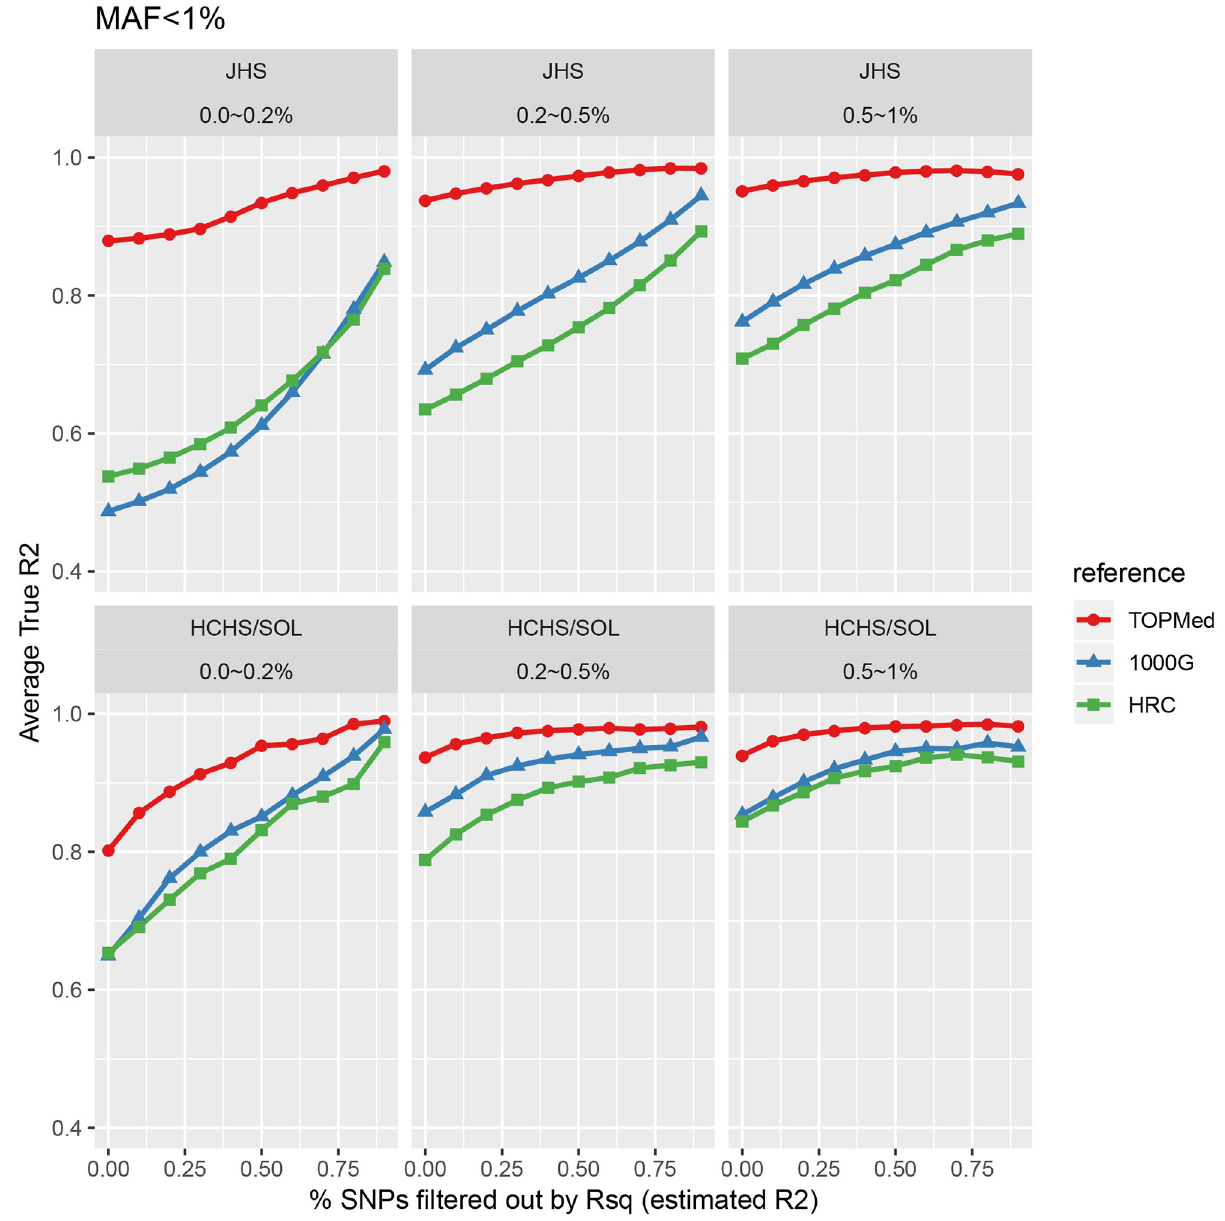
Fig 1. Comparison of imputation reference panels, for variants with MAF < 1%. Imputation quality (measured by true R2 [Y-axis]) is plotted with progressively more stringent post-imputation filtering from left to right, with filtering according to estimated R2 (X-axis), for variants with MAF < 1%. Top panels are for the JHS cohort and bottom panels for the HCHS/SOL cohort. Three reference panels are shown: TOPMed (TOPMed freeze 5b), 1000G (the 1000 Genomes Phase 3), and HRC (the Haplotype Reference